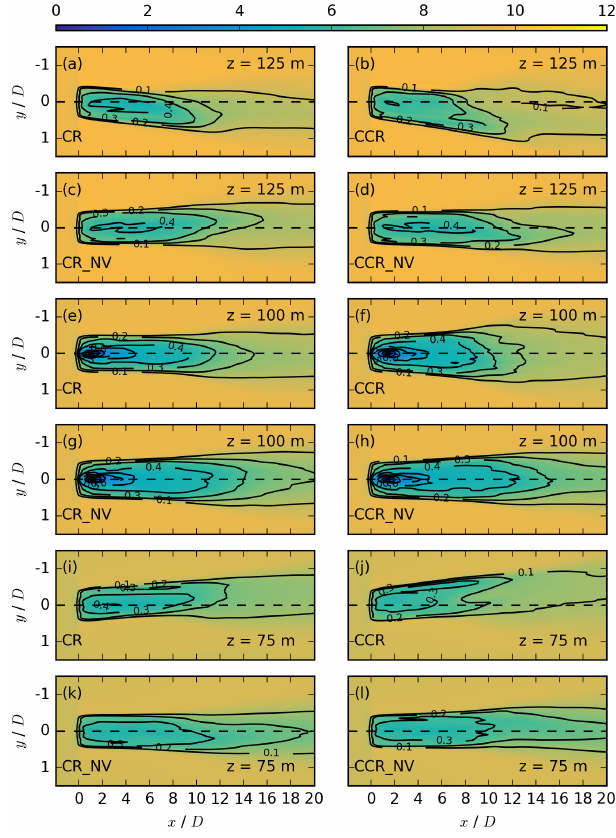
in meters per ∗ at the same ∗